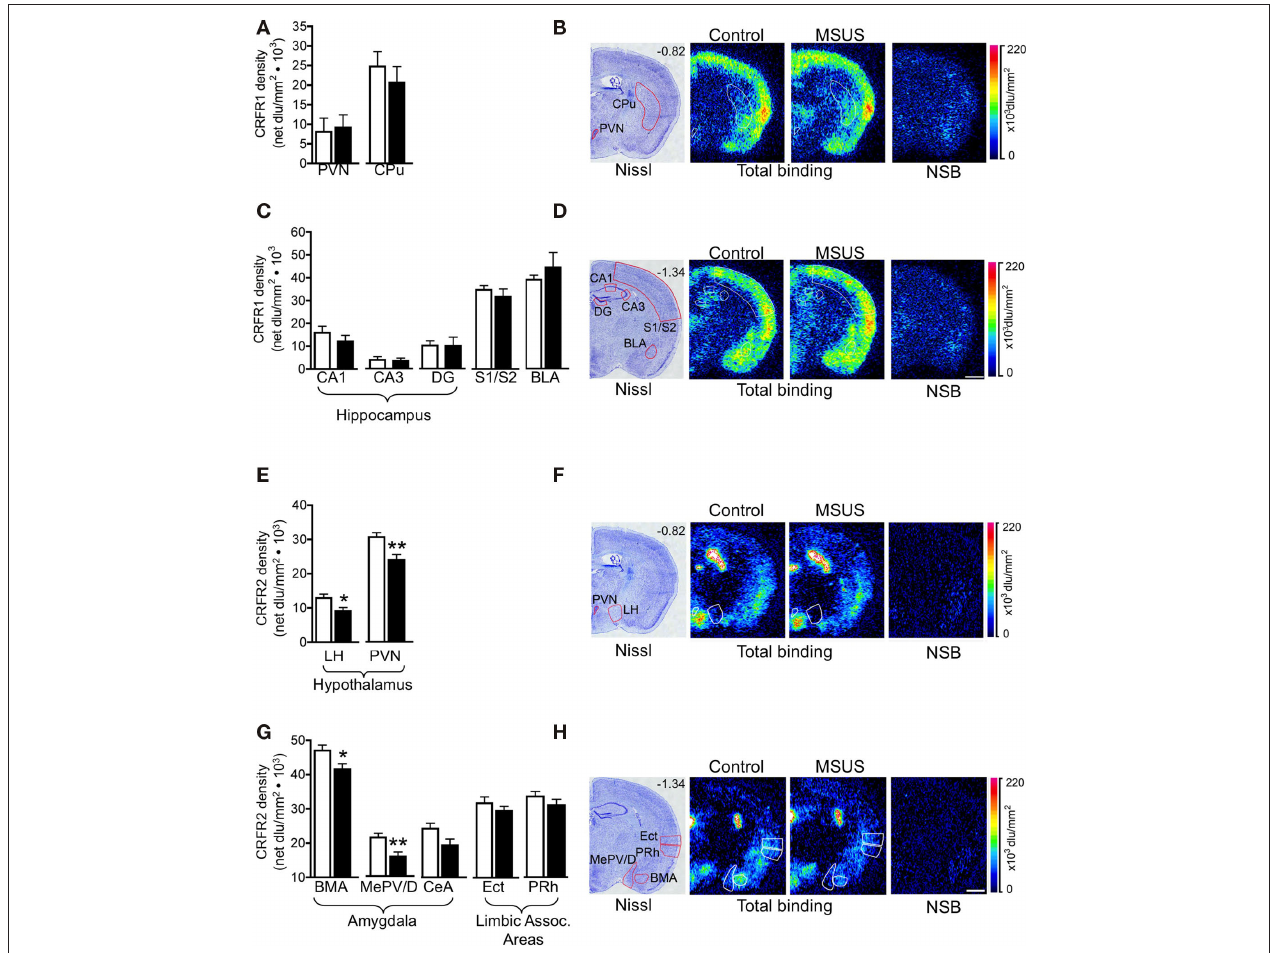
different brain areas in F 1 control and MSUS mice. Number in top right corner of Nissl section indicates Bregma position. Scale bar 1 mm. * p < 0.05; ** p < 0.01. BLA, basolateral amygdala; BMA, basomedial amygdala; CPu, caudate putamen; DG, dentate gyrus; Ect, ectorhinal cortex; LH, lateral hypothalamus; PVN, paraventricular nucleus; MePV/D, medial posteroventral and medial posterodorsal amygdala; PRh, perirhinal cortex; S1/S2, somatosensory cortex. Bar graphs represent mean values ±